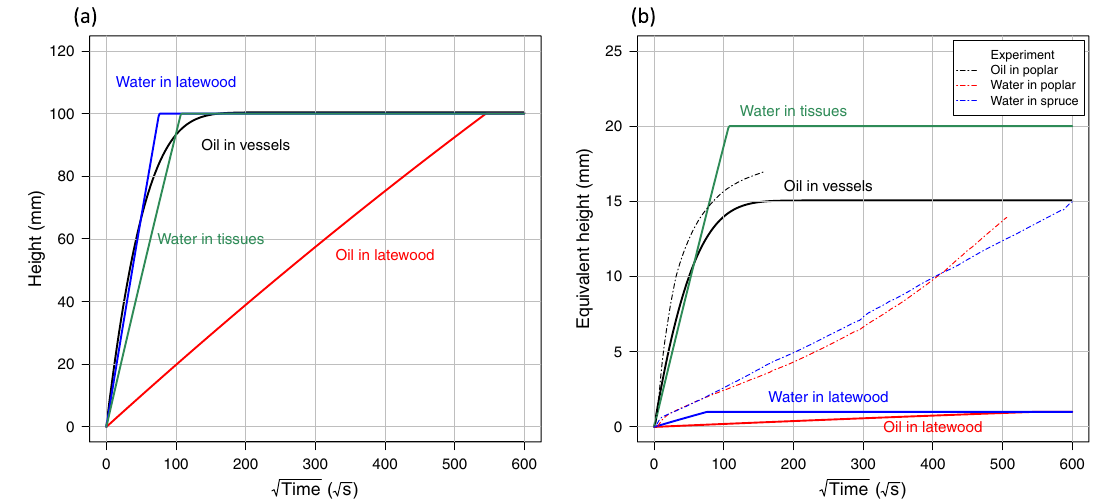
Figure 9. Imbibition modeling using a 1D Washburn formulation. The most important experimental curves are plotted in dashed lines for comparison purposes.